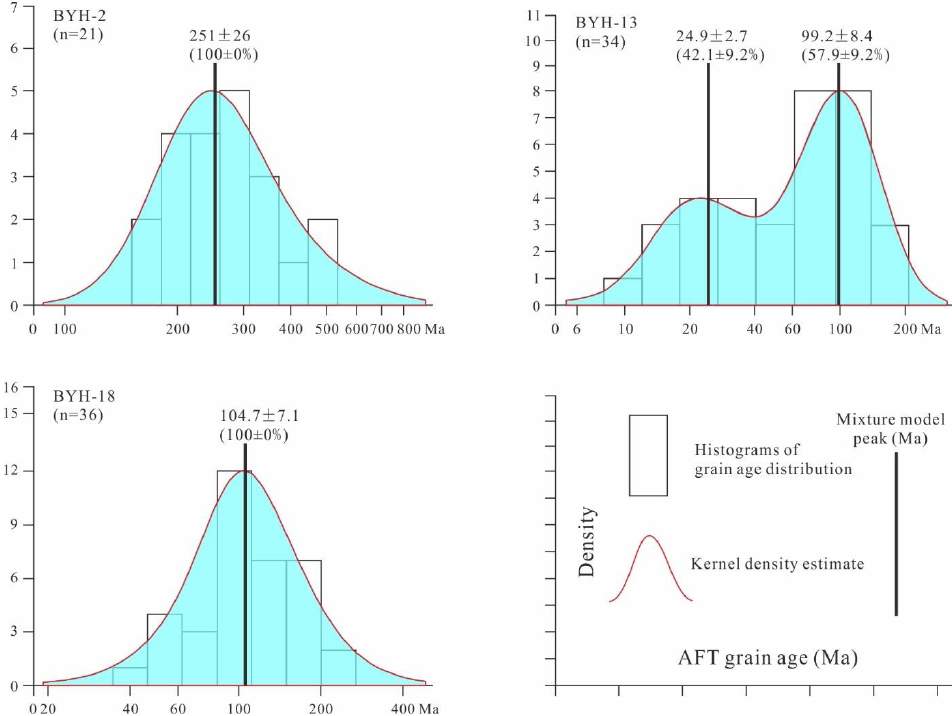
Figure 4. Density plot of apatite fission track ages. Density plots were constructed using the Radial Plotter program in [38].